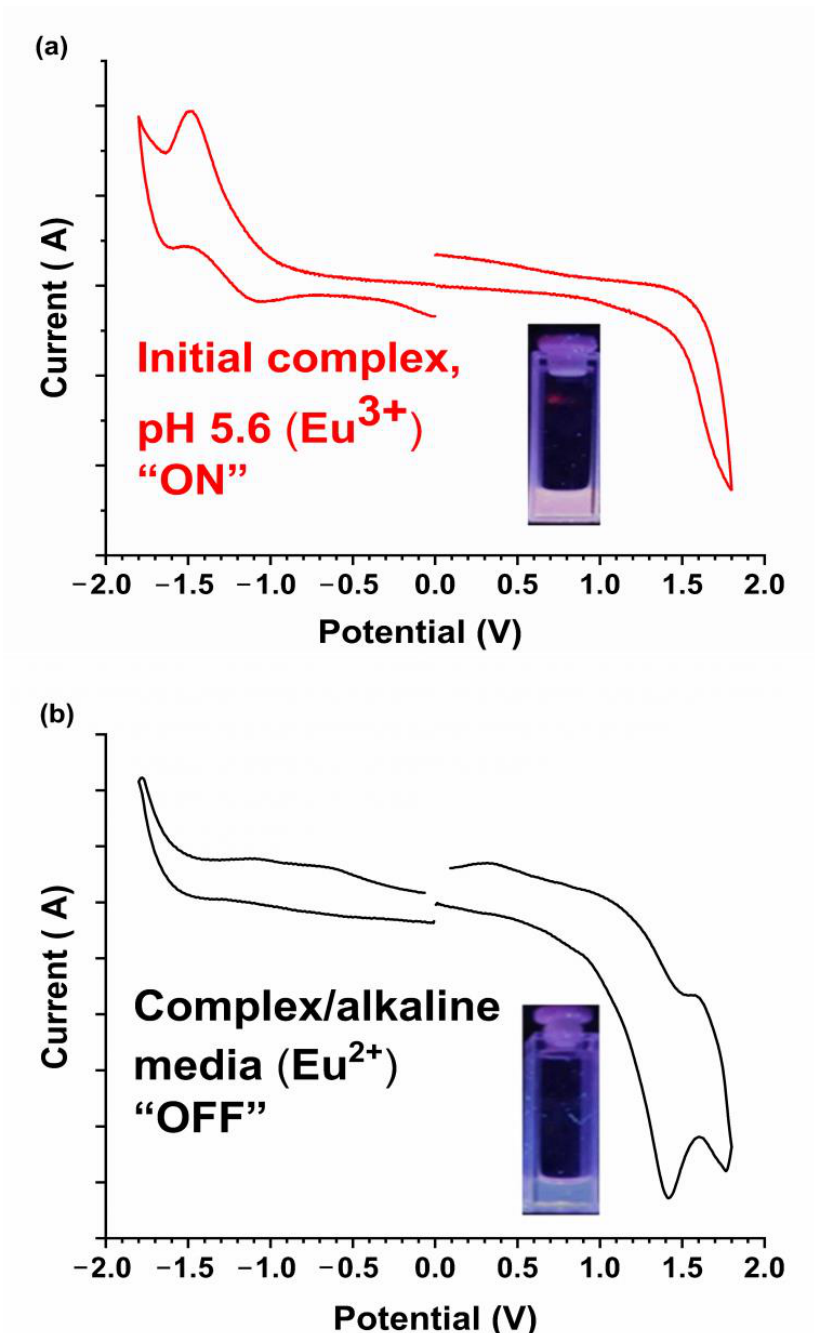
Figure 3. Cyclic voltammetry data for 1 at 0.5 mg/0.5 mL in dichlorobenzene solvent and TBAClO 4 electrolyte ( a ) at pH 5.6 and ( b ) at pH 8.0. The inset pictures show the complex under a UV lamp at the respective pHs.